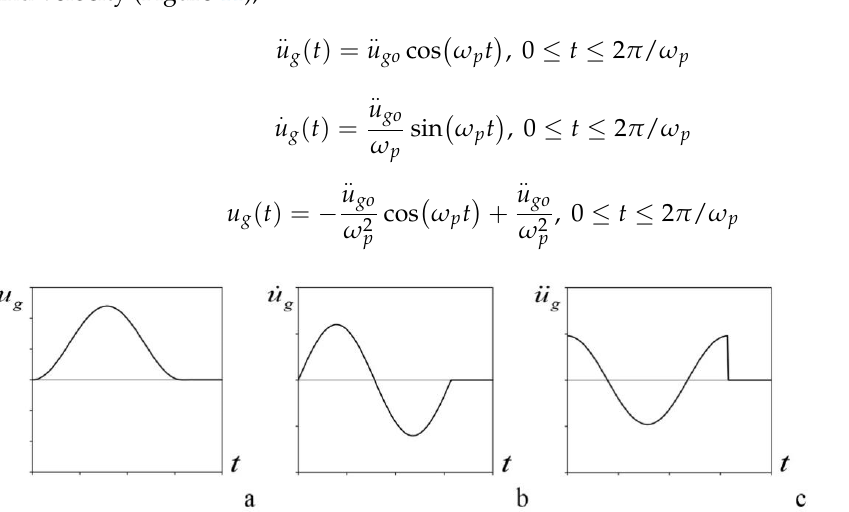
Figure 11. One-cosine pulse: ( a ) displacements, ( b ) velocity, and ( c ) acceleration time